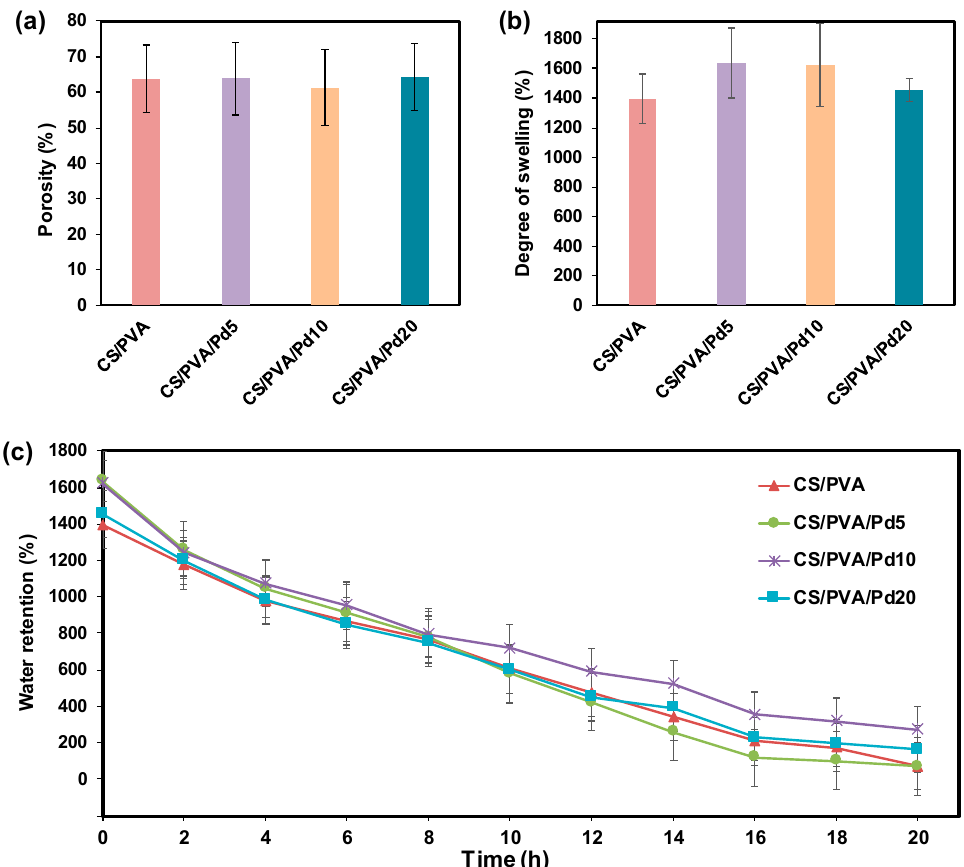
Figure6. ( a )Porosity, ( b )Degreeofswellingand( c )WaterretentionofCS / PVAandCS / PVA / Pddressings. Figure 6. ( a ) Porosity, ( b ) Degree of swelling and ( c ) Water retention of CS/PVA and CS/PVA/Pd dressings.